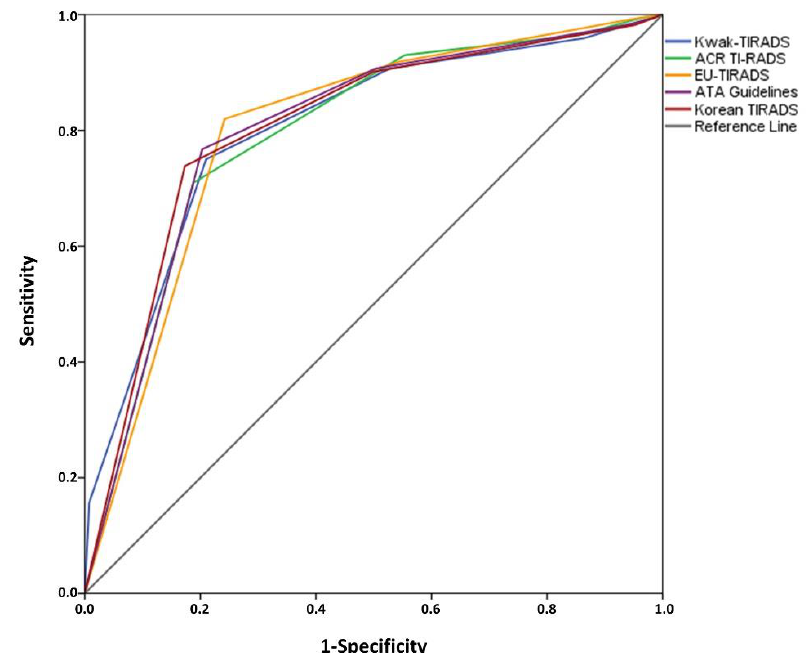
Figure 3. Receiver Operating Curves (ROCs) of the risk stratification systems (RSSs) *. * Thyroid nodules (TNs) that were not classifiable (N/A) are not included. Table 5. Comparison of Area under the Curve (AUC) values between the investigated risk stratifi- cation systems (RSSs) via Hanley and McNeil Test